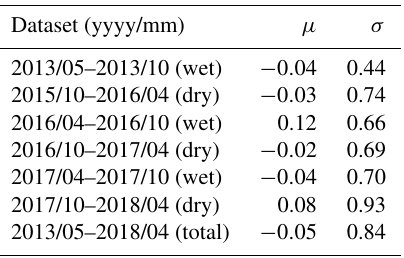
Table 4. Off-glacier elevation differences on stable terrain. These differences can be seen as the vertical accuracy of that specific dataset. Values are in metres.